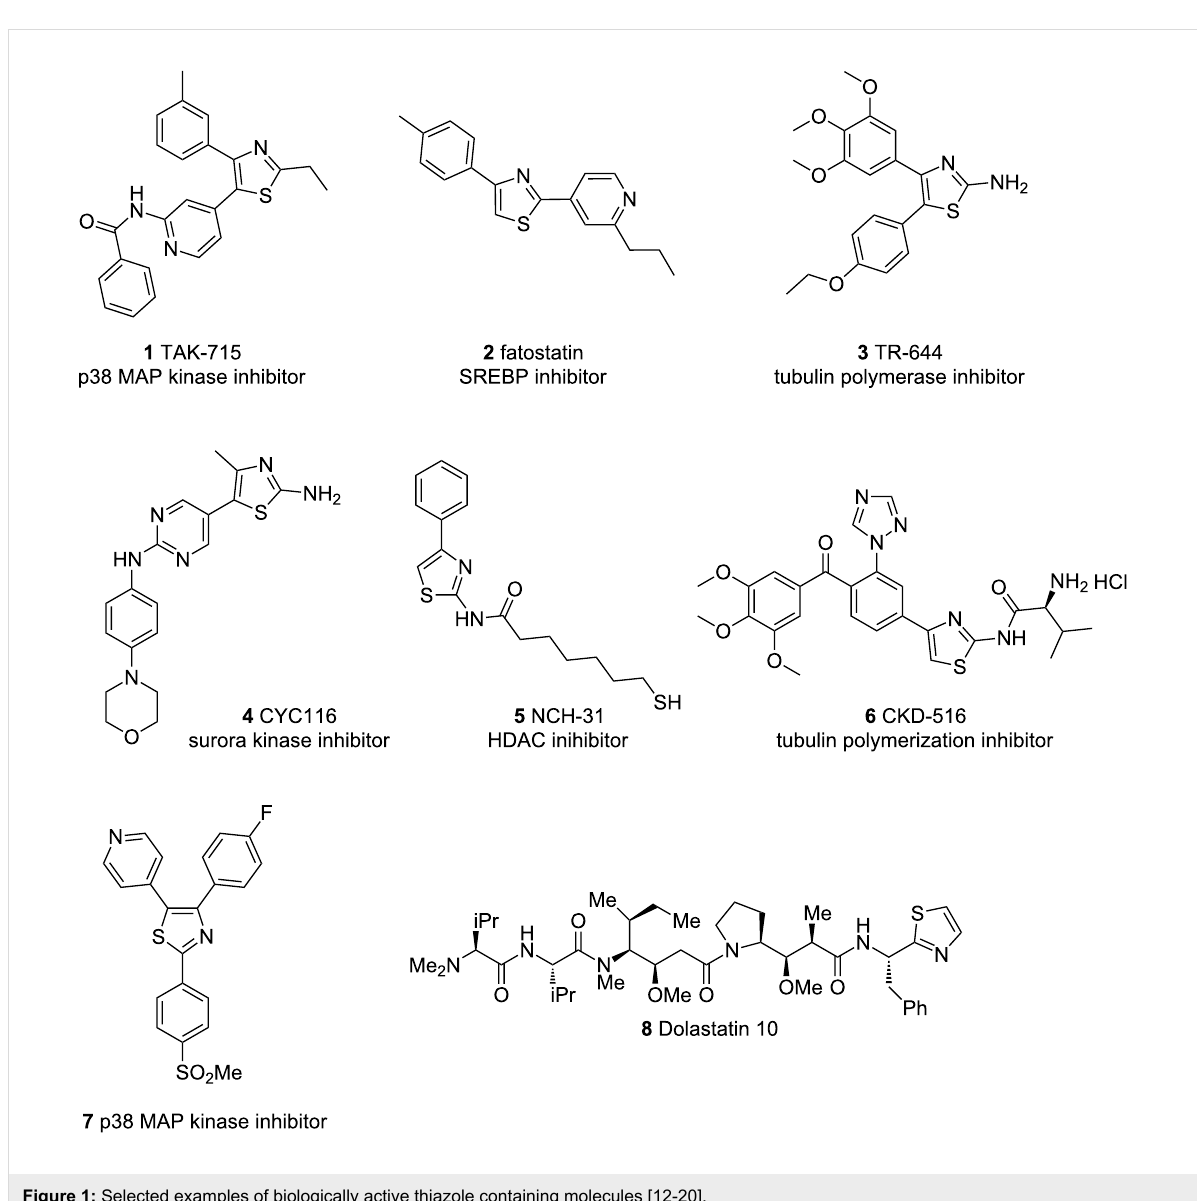
Figure 1: Selected examples of biologically active thiazole containing molecules